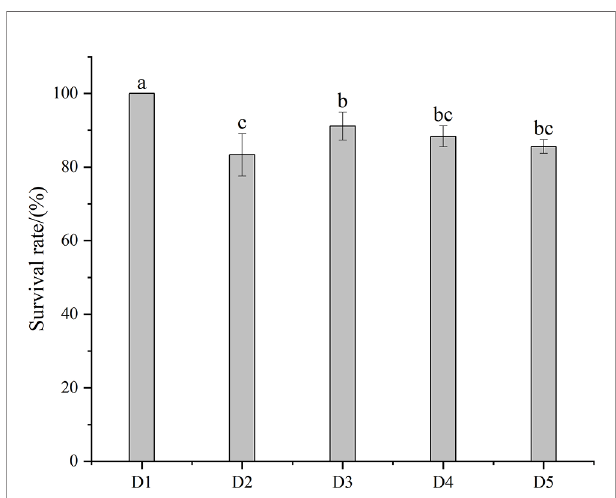
FIGURE 1 | The survival rate after transportation at fi ve different densities. Different letters above bars indicate signi fi cant differences at the 0.05